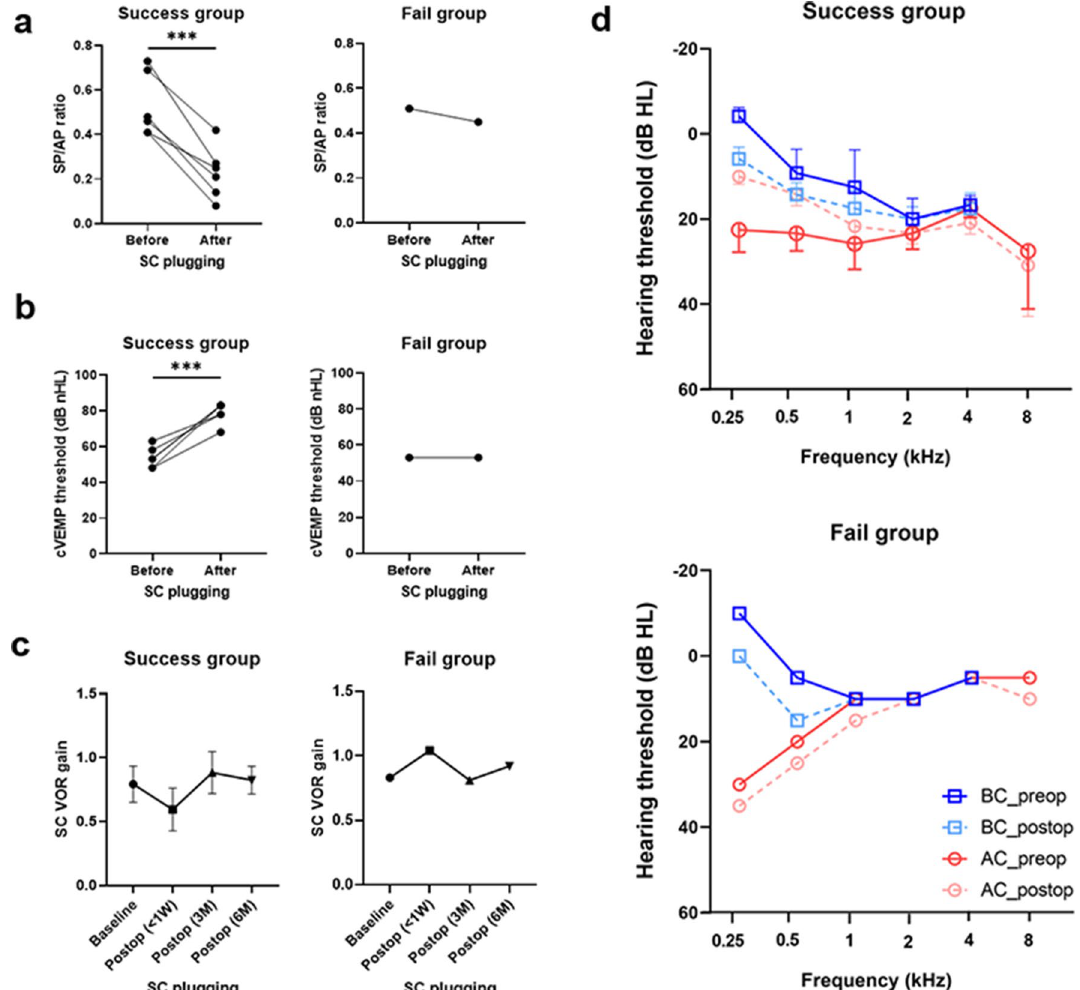
Figure 3. Changes in electrophysiological, vestibular, and audiological functions following SC plugging between the success and failure groups. ( a ) Summating potential/action potential ratios before and after surgery for all patients. Preoperative and postoperative gain values for the same patient are connected by a line. At 3 months after surgery, the mean summating potential/action potential ratio for operated ears had increased significantly in the success group (P < 0.001, paired t-test) but not in the failure group. ***P < 0.001. ( b ) Cervical vestibular evoked myogenic potential (cVEMP) threshold before and after surgery for all patients. At 3 months after surgery, the mean cVEMP threshold (dB nHL) in operated ears increased in the success group (P < 0.001, paired t-test) but not in the failure group. ( c ) Natural course of the mean vestibulo-ocular reflex (VOR) gain in the SC over 1 year (before and after surgical plugging). ***P < 0.001. In the success group, the mean VOR gain for plugged SCs decreased immediately (within 1 week after surgery) but improved over time to reach the preoperative value. By contrast, a fluctuating pattern for the VOR gain in the plugged SC over time was observed in the failure group. Data are presented as means ± standard errors of the mean. ( d ) Preoperative and postoperative bone conduction and air conduction thresholds are shown for all tested frequencies. In the success group, air-bone gaps (ABGs) were significantly reduced after SC plugging, particularly at low frequencies (250 and 500 Hz), due to elevated bone conduction thresholds and reduced air conduction thresholds at low frequencies (250 and 500 Hz), indicating significant improvements (P < 0.001, paired t-test). By contrast, the ABGs remained unchanged in the failure